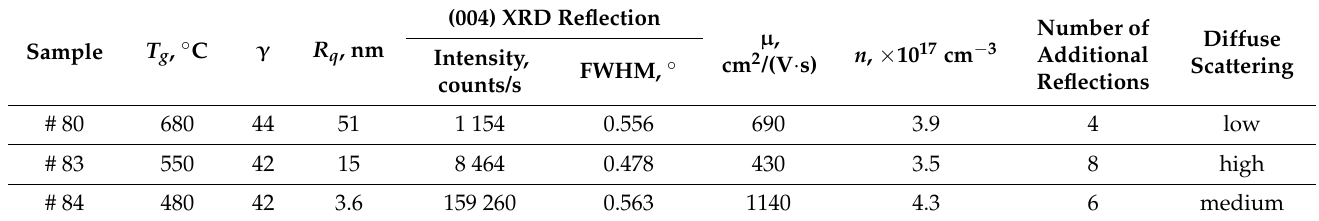
Table 2. Features of crystal structure and defectiveness degree of samples 80, 83,